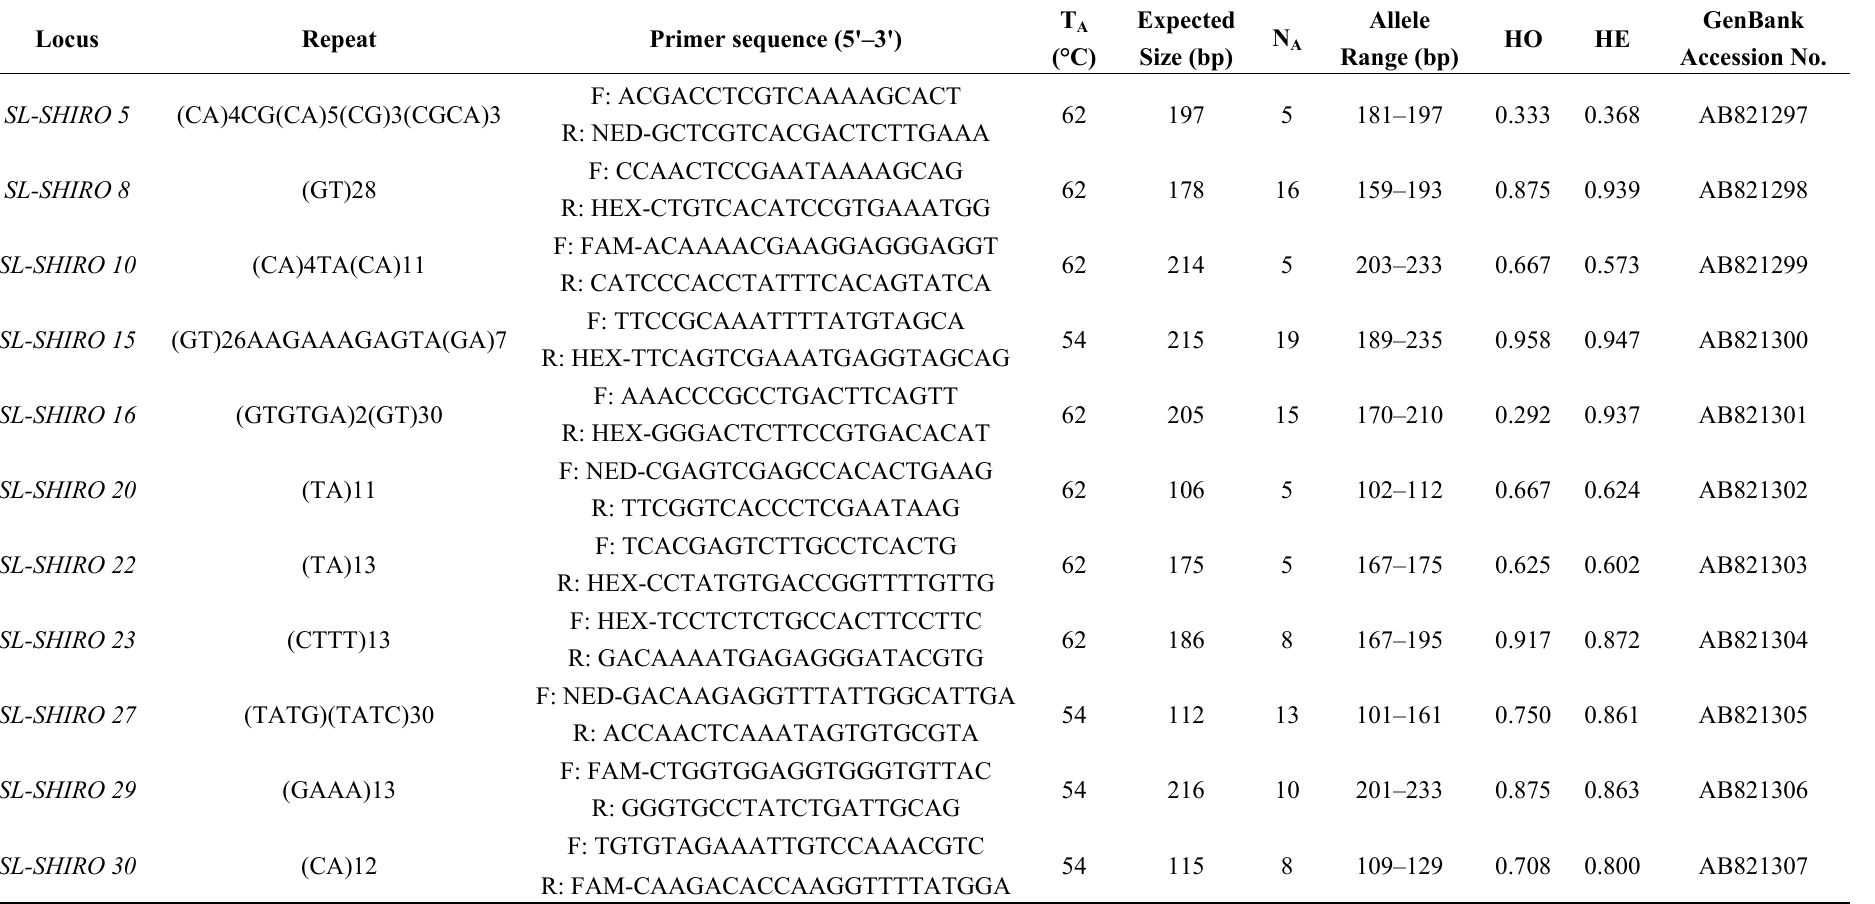
Table 1. Characterization of 11 microsatellite loci for the oval squid Sepioteuthis lessoniana